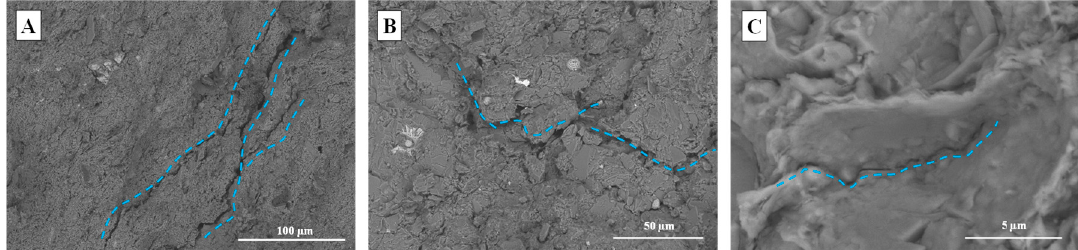
Figure 6. Shrinkage of OM, arrows indicate vacated space around an inclusion. SEM images of the sample #16 after the experiment.